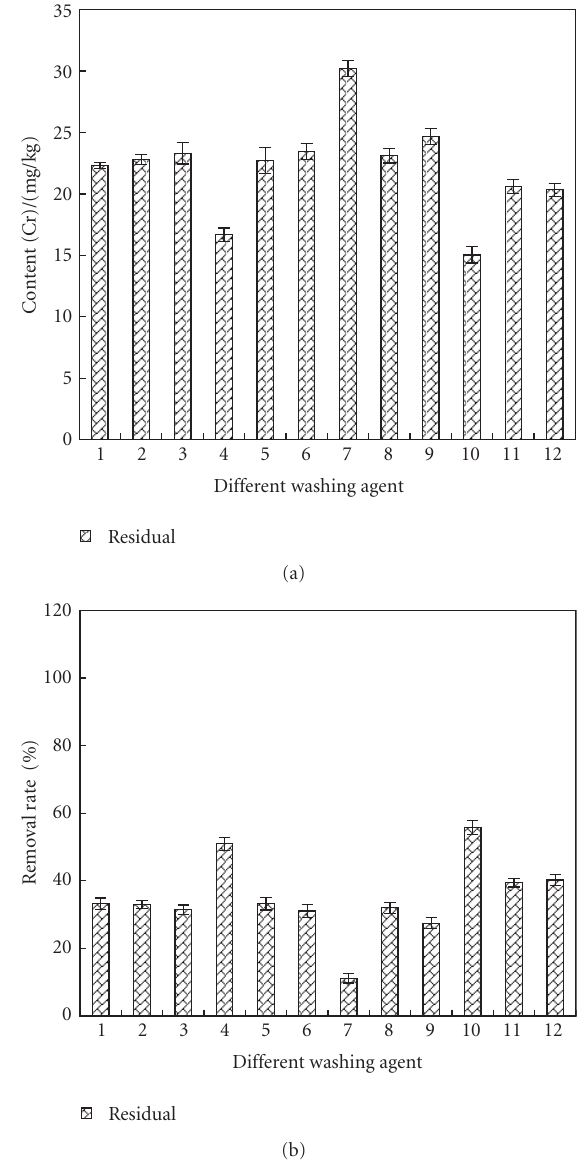
Figure 11: Removal e ff ect of residual Cr by di ff erent washing agents. Washing agent: 1—water; 2—0.05 mol/L EDTA-Na 2 ; 3— 0.1mol/L EDTA-Na 2 ; 4—0.1 mol/L citric acid; 5—0.5 mol/L citric acid; 6—0.1 mol/L oxalic acid; 7—0.5 mol/L oxalic acid; 8— 0.1mol/L HCl; 9—0.5 mol/L HCl; 10—1mol/L HCl; 11—0.1 mol/L acetic acid; 12—0.5 mol/L acetic